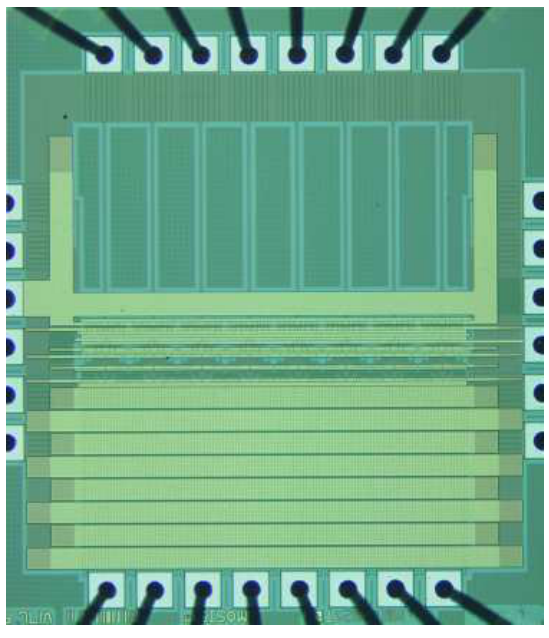
Figure 4. A micrograph of the fabricated 1 . 5 mm × 1 . 5 mm